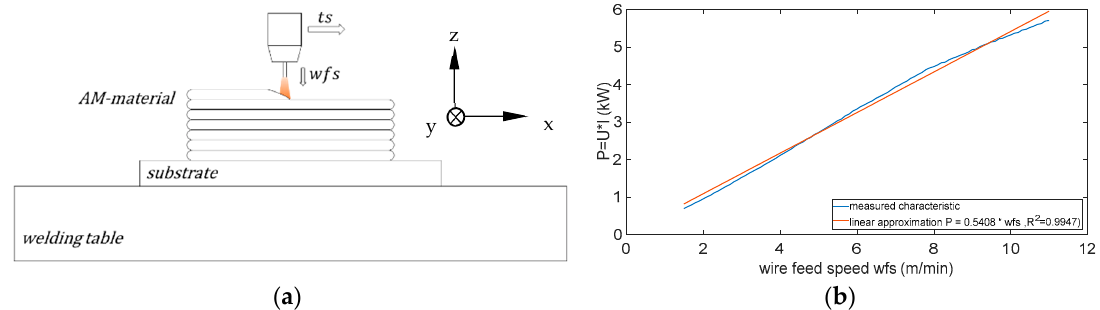
Figure 2. ( a ) Illustration of the WAAM (wire + arc additive manufacturing) process with build orientation and the main influencing factors travel speed ( ts ) and wire feed speed ( wfs ); ( b ) Universal CMT (Cold Metal Transfer) characteristic 3148 for steel.